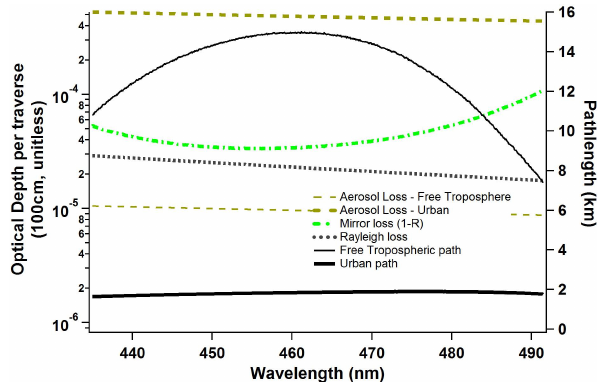
Fig. 1. Aerosols can strongly affect the effective path length. The wavelength dependent extinction losses (dotted lines) are: mirror loss (1 − R ) of our cavity (green dashed-dotted line), Rayleigh scat- tering loss of air at 1atm (gray dotted line), and aerosol losses for two scenarios: free tropospheric conditions ( ε Mie =1 × 10 − 7 cm − 1 at 450nm, thin dashed line); and polluted urban conditions (5 × 10 − 6 cm − 1 at 450nm, thick dashed line). The wavelength de- pendence of aerosol extinction was approximated as λ − 1 . 5 . The corresponding effective path length for both scenarios is shown by the respective solid